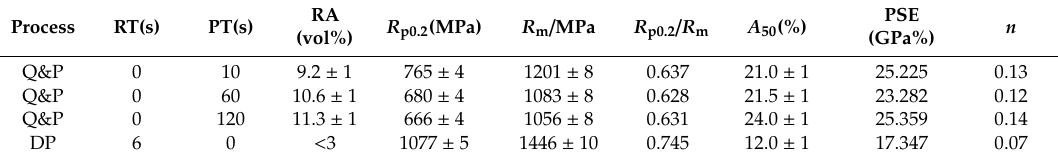
Table 1. Mechanical properties of the test steel.